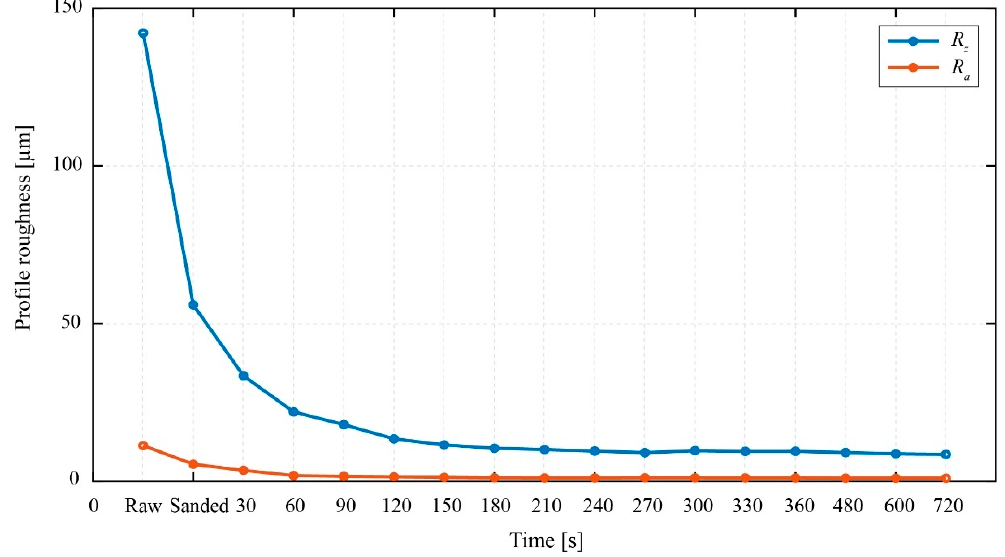
Figure 6. The roughness value R z of the MC 901 gear during the treatment process.